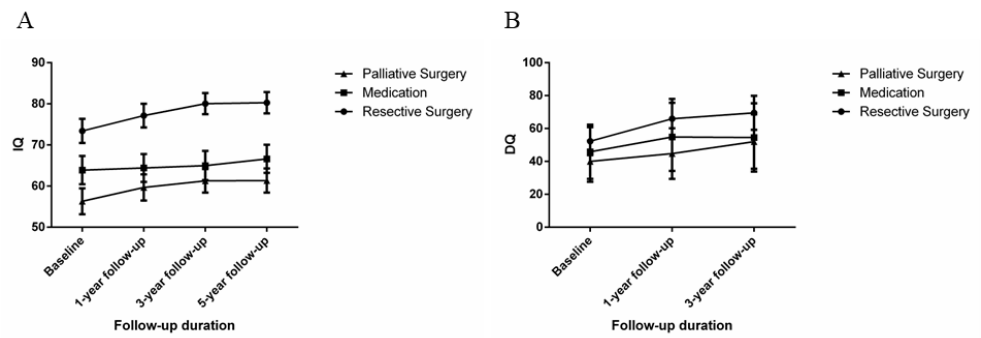
Figure 4. ( A , B ) The changes in IQ and DQ of children with drug-resistant epilepsy after different treatment regimens, respectively. It was worth noting that the Chinese version of the Gesell Devel- opmental Schedules was only suitable for children under 6 years of age. Here we only listed the developmental quotients of 63 children who were suitable for observing the changes at follow-up.